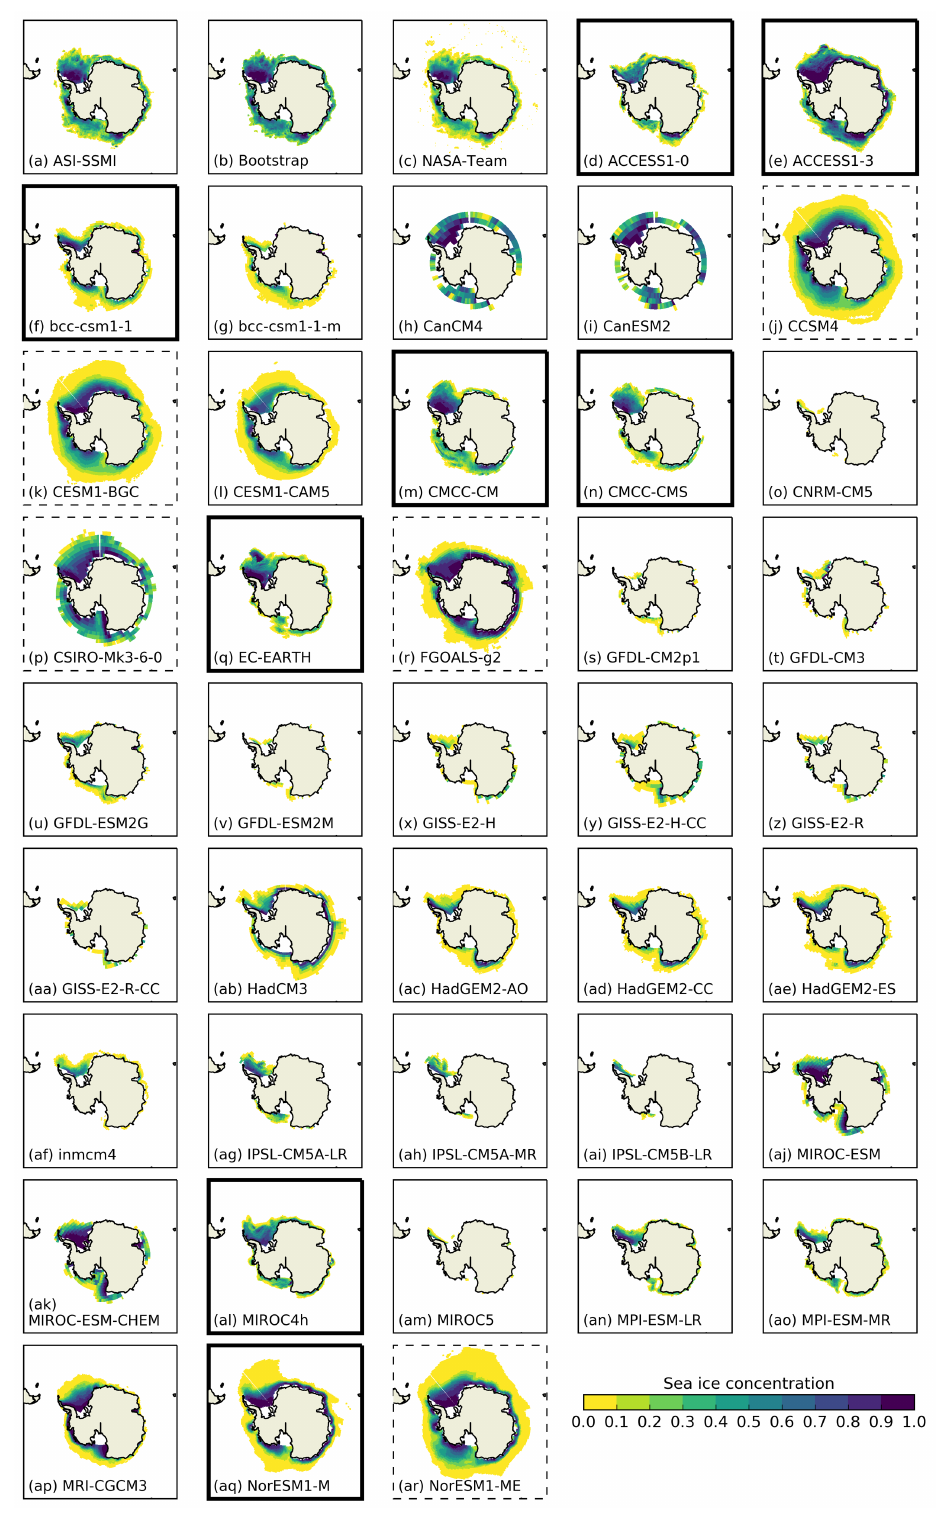
Figure 3. Sea ice concentrations (above 0.1%) for the three sets of observations (a–c) and the CMIP5 models (d–ar) for the month of each model or observation’s sea ice area minimum, averaged over 1992–2014. Models marked with a bold (dashed) bounding box have high-ranked (low-ranked) integrated ice area errors regardless of observational product used. Integrated ice area errors consider sea ice concentrations > 15% for the sea ice field